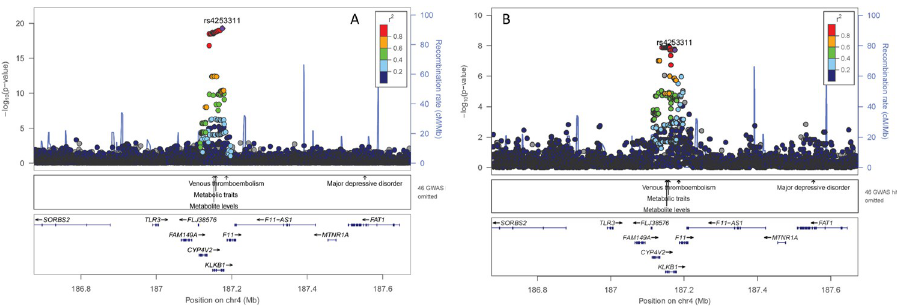
Fig 2. Regional association plot for the region around rs4253311 on chromosome 4: (A) GCKD study (discovery) and (B) YFS cohort (replication). Plots are produced in LocusZoom and show the most strongly associated SNP (purple diamond), SNP colors reflect LD correlation (r 2 ) using 1000G EUR population as reference. The -log 10 p- values (left y-axis) of SNPs are shown according to their chromosomal positions (x-axis, GRCh37); the genetic recombination rates are shown on the right y-axis. The -log 10 p-values are shown for both genotyped and imputed SNPs distributed in a 0.8-megabase genomic region.